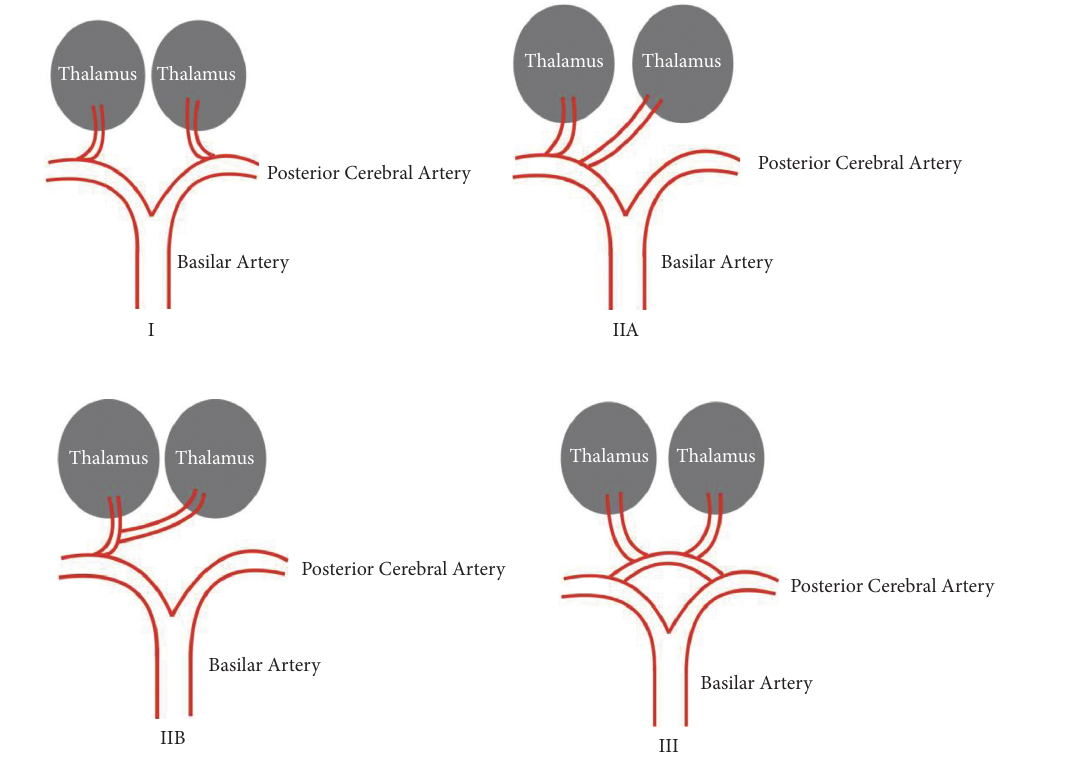
Figure 1: Anatomy of thalamic arterial supply variants. Table 1: Description of thalamic arterial supply